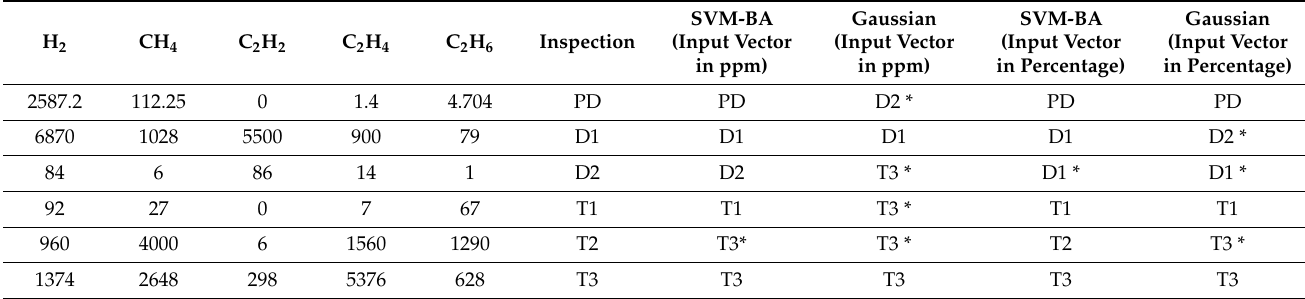
Table 3. Diagnosis results of some cases.